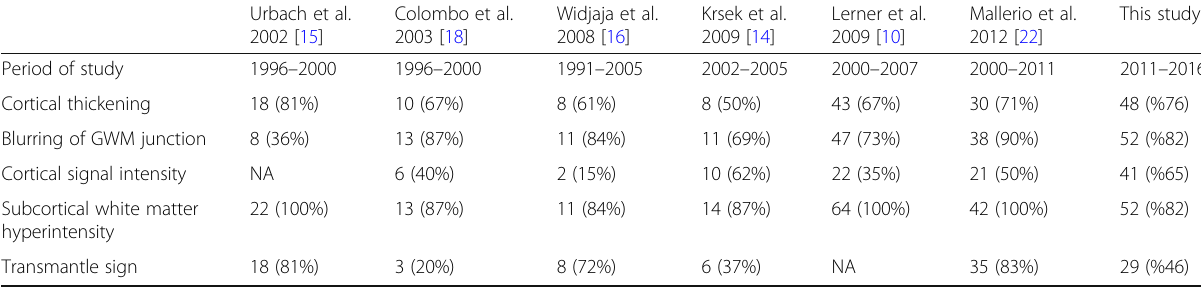
Table 7 Typical MR imaging findings of FCD type 2 that have been reported in the literature and histologically